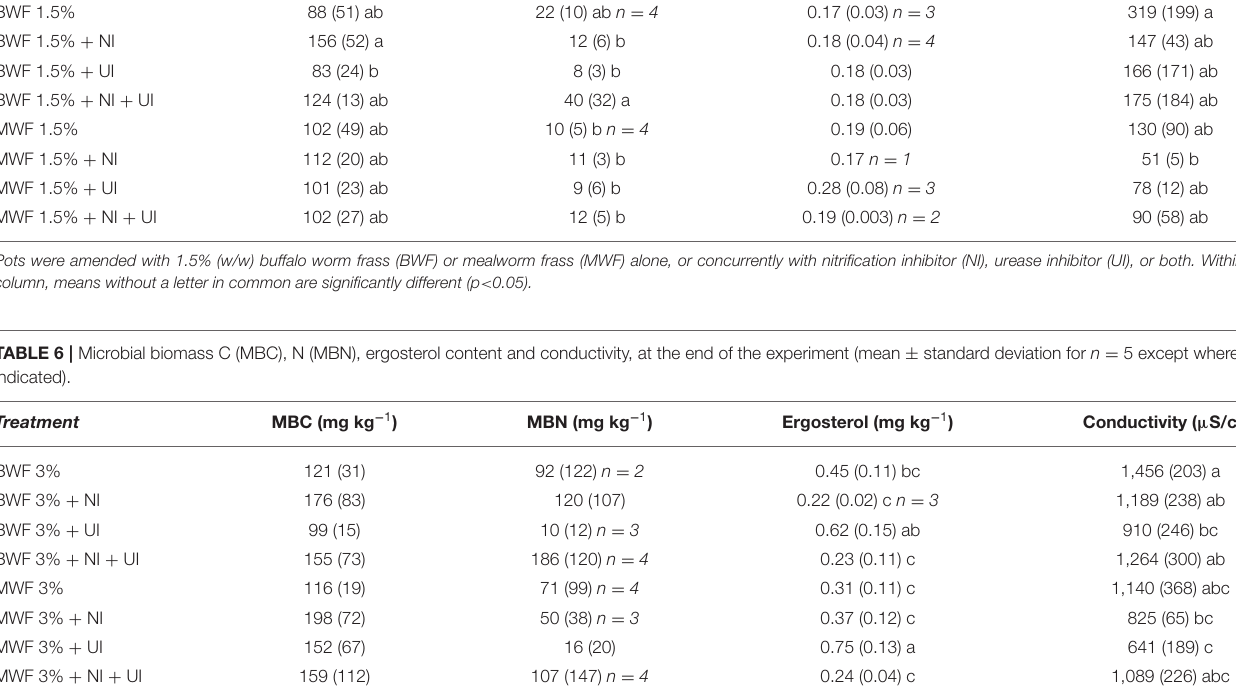
TABLE 5 | Microbial biomass C (MBC), N (MBN), ergosterol content and conductivity at the end of the experiment (mean ± standard deviation for n = 5 except where indicated). Treatment